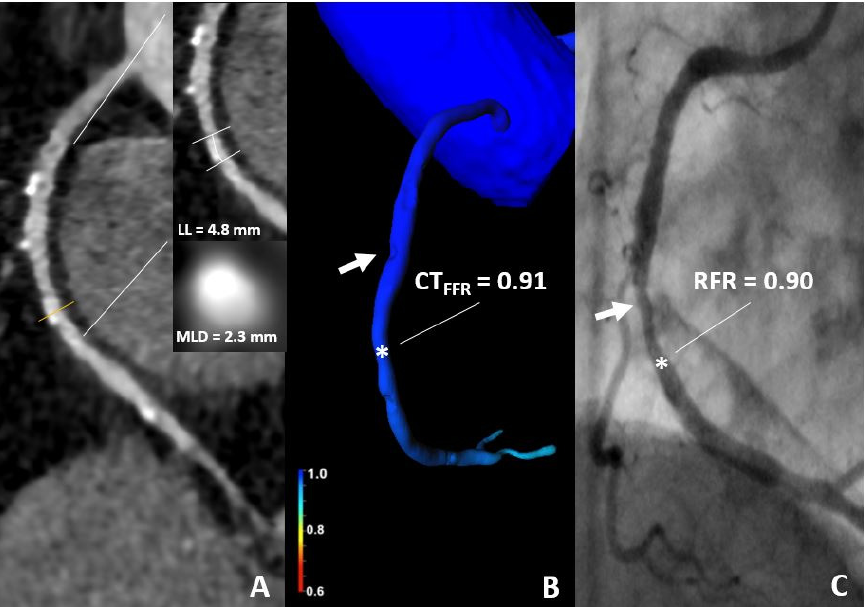
Figure 4. 86-year-old woman. ( A ) CT demonstrates a 60% stenosis of the mid segment of the RCA. ( B ) The CT-FFR value was 0.91 (star). ( C ) An ICA with RFR value of 0.90 (star) shows a non-significant stenosis. CT, computed tomography; CT-FFR, coronary computed tomography angiography based fractional flow reserve; RFR, resting full cycle Ratio; LL, lesion length; MLD, minimal luminal diameter.